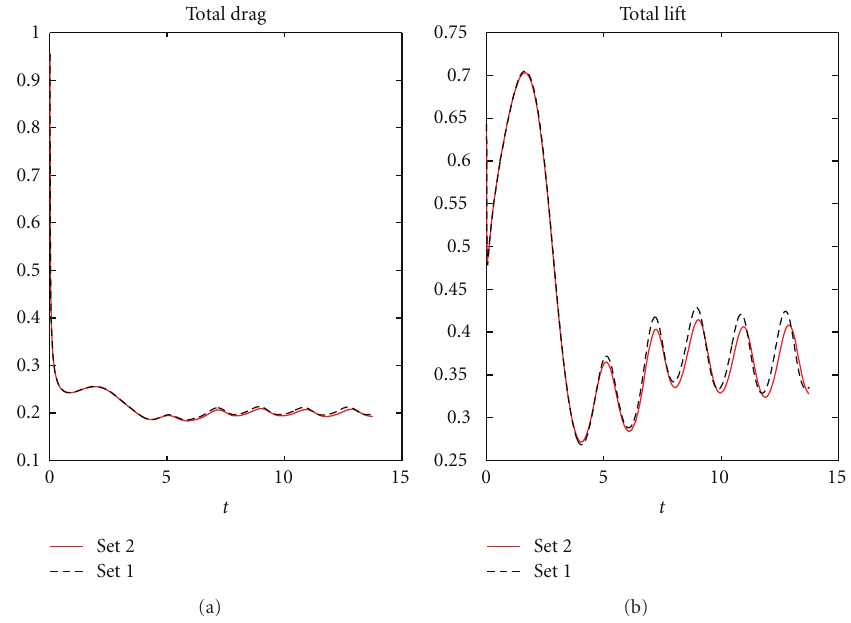
Figure 15: Drag and lift coe ffi cients when using M = 2 and M = 3.